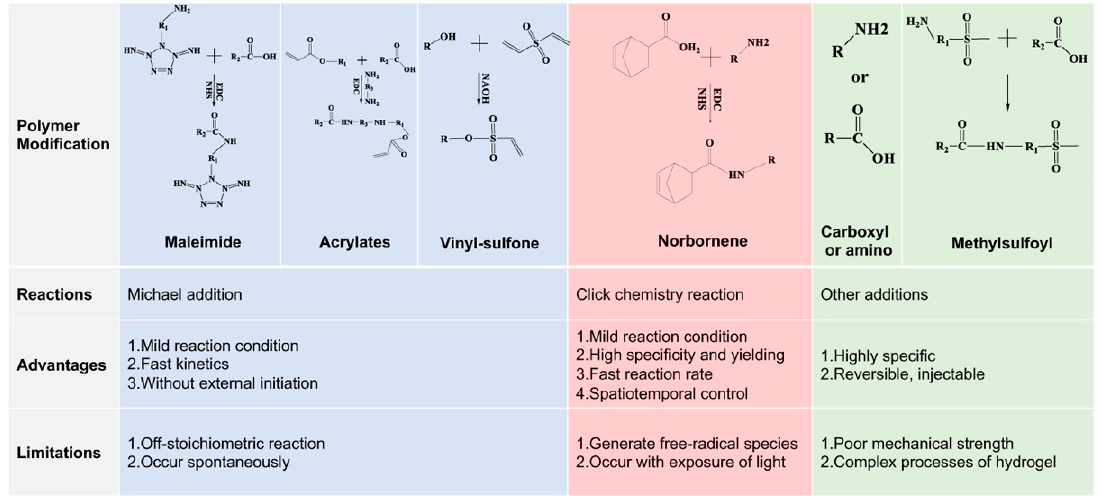
Figure 4. Polymer modifications, reactions, advantages and limitations of MMP-cleavable peptides-based hydrogels.